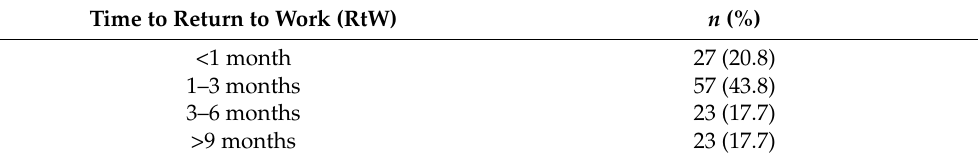
Table 5. Time to return to work.